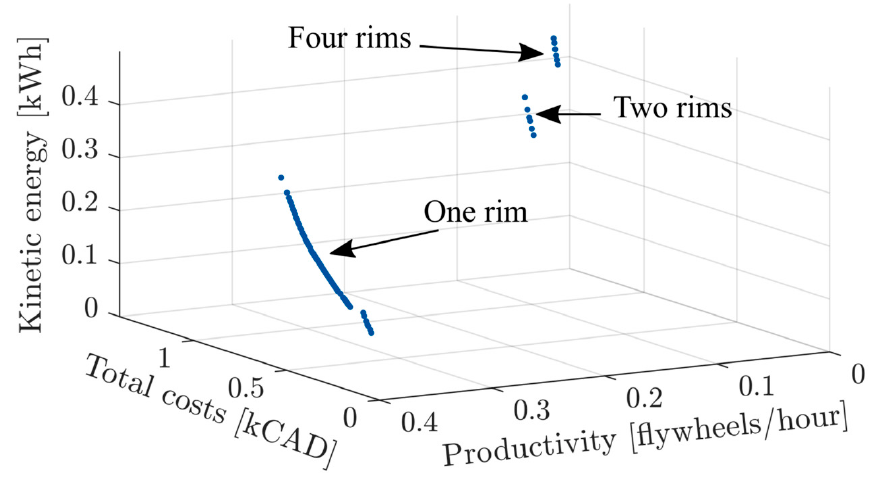
Figure 5. Three ‐ dimensional Pareto ‐ front of the ACME geometry.